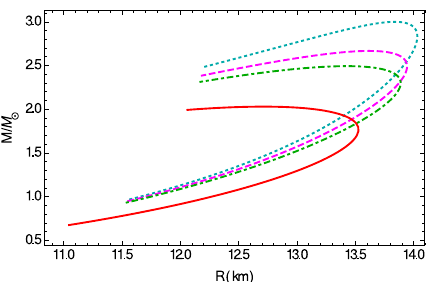
Fig. 12 Variationof ¯ ζ (leftpanel)andoftheHiggs-typepotential ¯ V (ζ) (rightpanel)forthree-formphotonstarsasfunctionsof η ,for ¯ a = 0 . 007 and three different values of the constant ¯ b , and for three different val- ues of the constant ¯ b : ¯ b = 0 (dashed curve), ¯ b = − 0 . 11 (dotted curve),